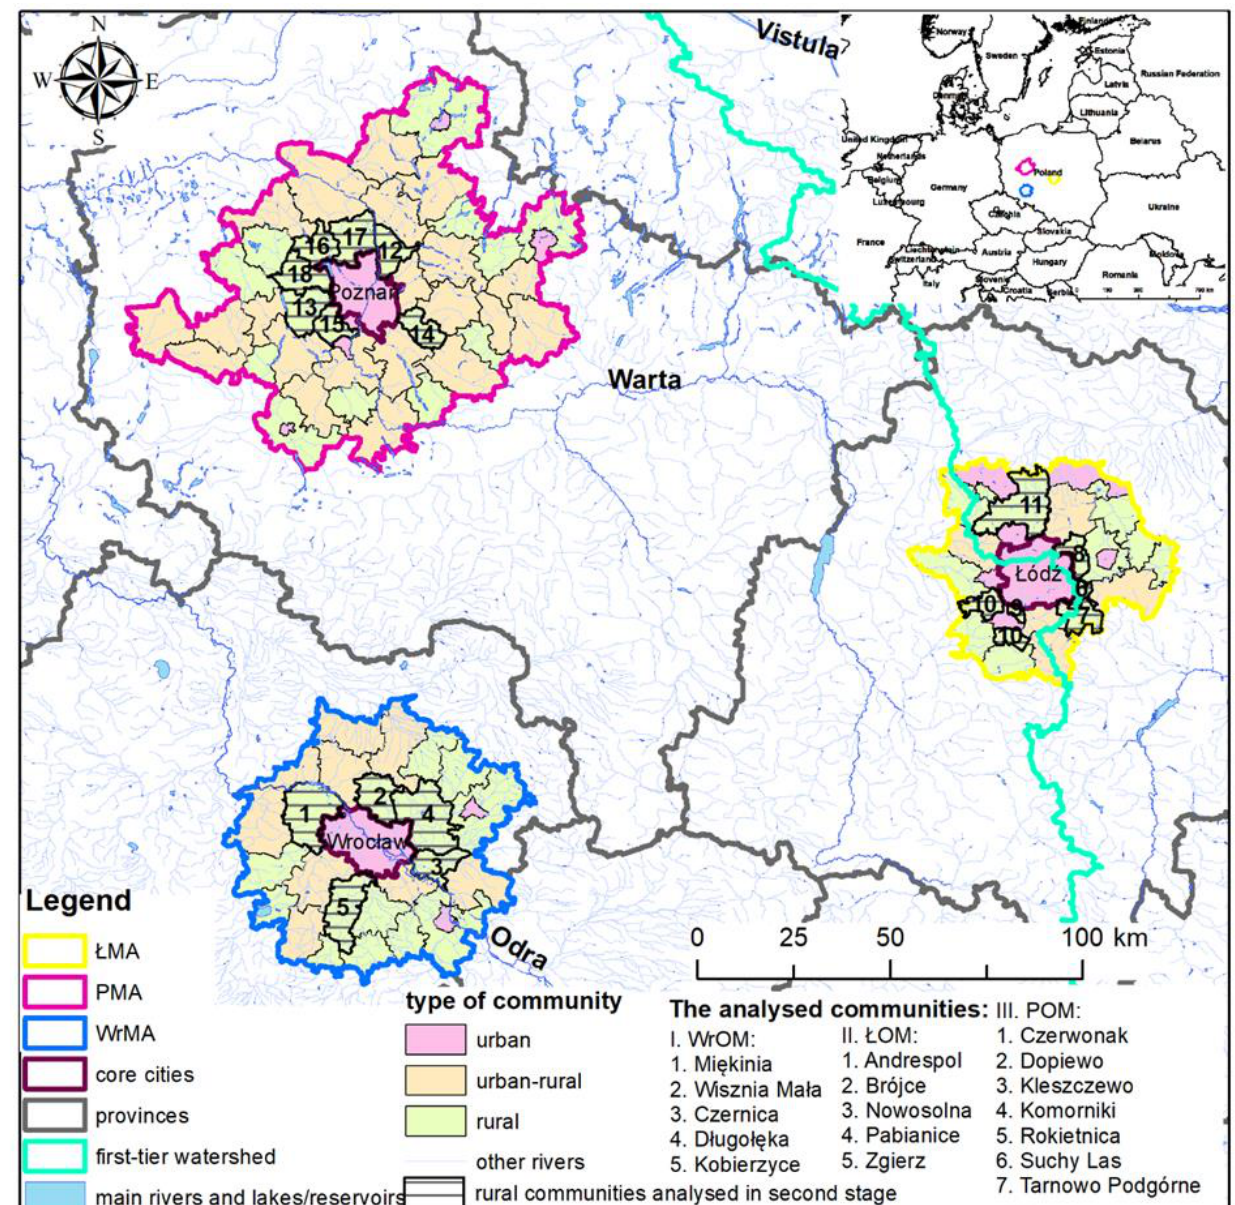
Figure 2. Location of the analyzed rural communities and metropolitan areas.